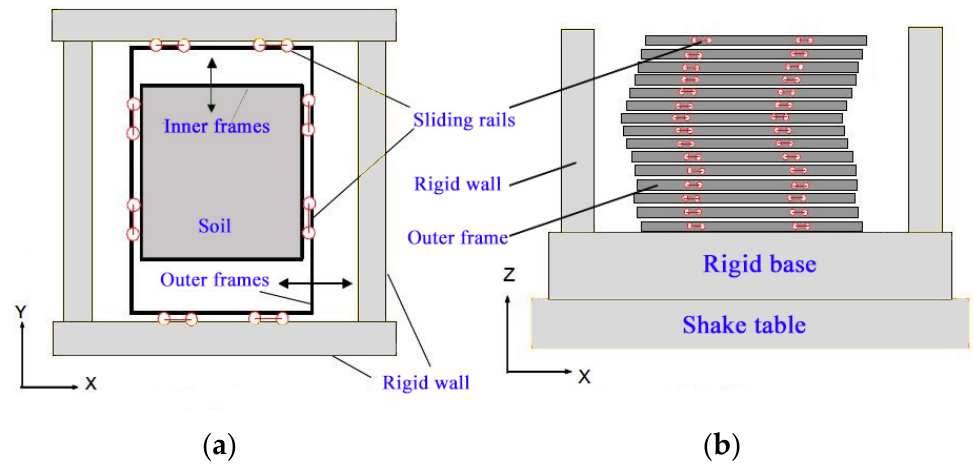
Figure 14. Schematic drawings of the biaxial laminar box (From [60]; modified): ( a ) top view and ( b ) side view. Table 1. Examples of laminar shear boxes.